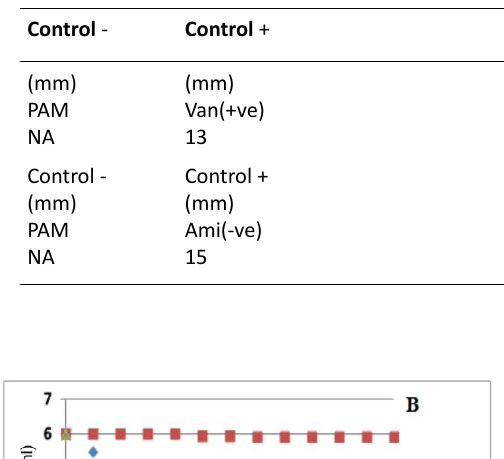
-SWCNT photocatalyst 6 -SWCNT during different 6